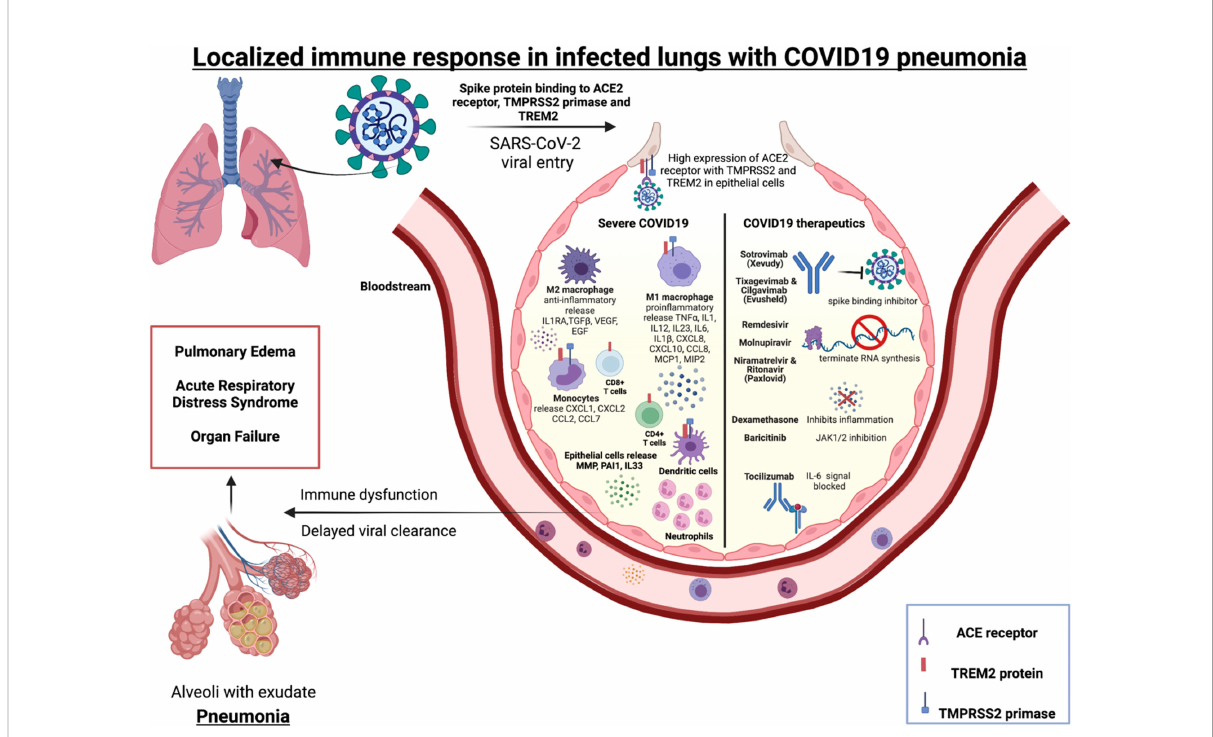
FIGURE 1 Immune mediators of severe COVID-19 and targets for licensed therapeutics. Alveolus left side: Immune cells (macrophages, monocytes, T cells, neutrophils and dendritic cells) localized in the lungs release speci fi c cytokines and chemokines along with high neutrophil to lymphocyte ratio (NLR) during severe COVID-19 pneumonitis. Alveolus right side: Molecular mechanism of action of COVID-19 therapeutics include blocking the spike binding receptor (Xevudy), terminating viral RNA synthesis (Remdesvir, Niramatrelvir, Ritonavir, Molnupiravir). Corticosteroids (Dexamethasone) block transcription of glucocorticoid-responsive genes, many of which are pro-in fl ammatory e.g. Type 1 interferons. Janus kinase (JAK) inhibitors that block the signalling pathway (Baricitinab). IL-6 signalling can also be targeted